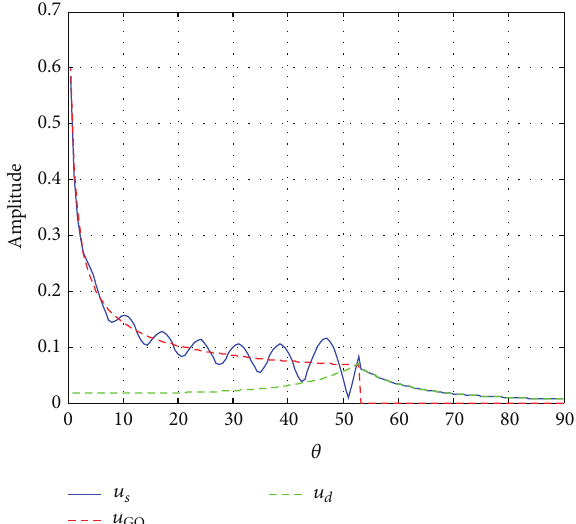
Figure 4: Scattered represented by 𝑢 𝑠 , geometric optics represented , and diffracted represented by 𝑢 𝑑 fields. The observation by 𝑢 GO distance 𝑟 is 10𝜆 and the aperture size 𝑎 is 2𝜆 .